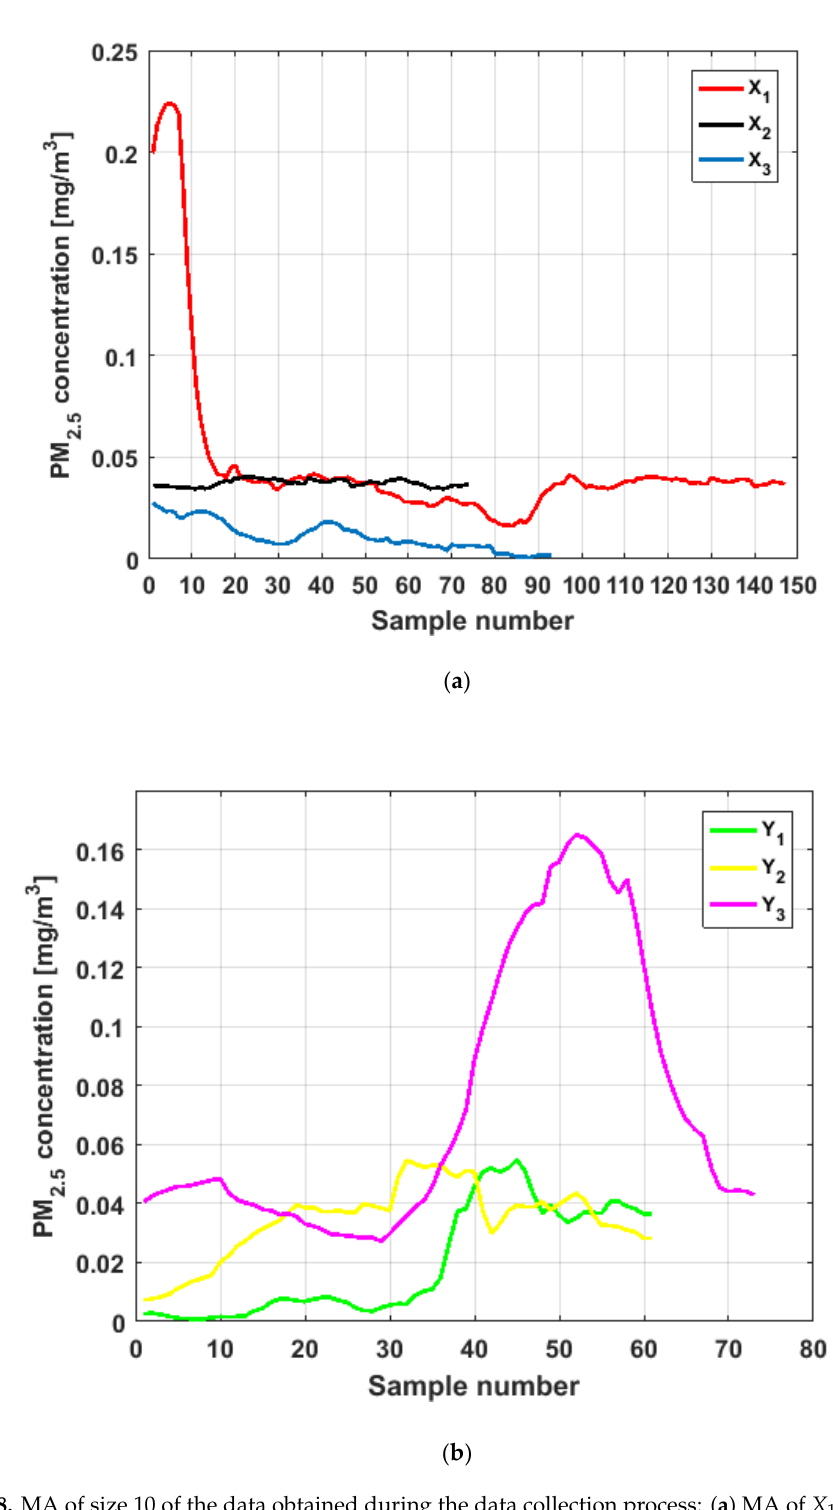
Figure 8. MA of size 10 of the data obtained during the data collection process: ( a ) MA of 𝑋 1 , 𝑋 2 , and 𝑋 3 ; ( b ) MA of 𝑌 1 , 𝑌 2 , and 𝑌 3 . X 3 ; ( b ) MA of Y 1 , Y 2 , and Y 3